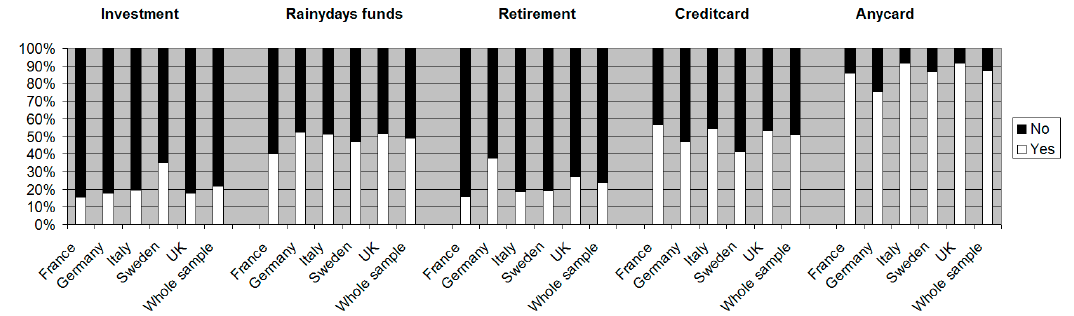
Figure 1. Financial behaviors (dependent variables).